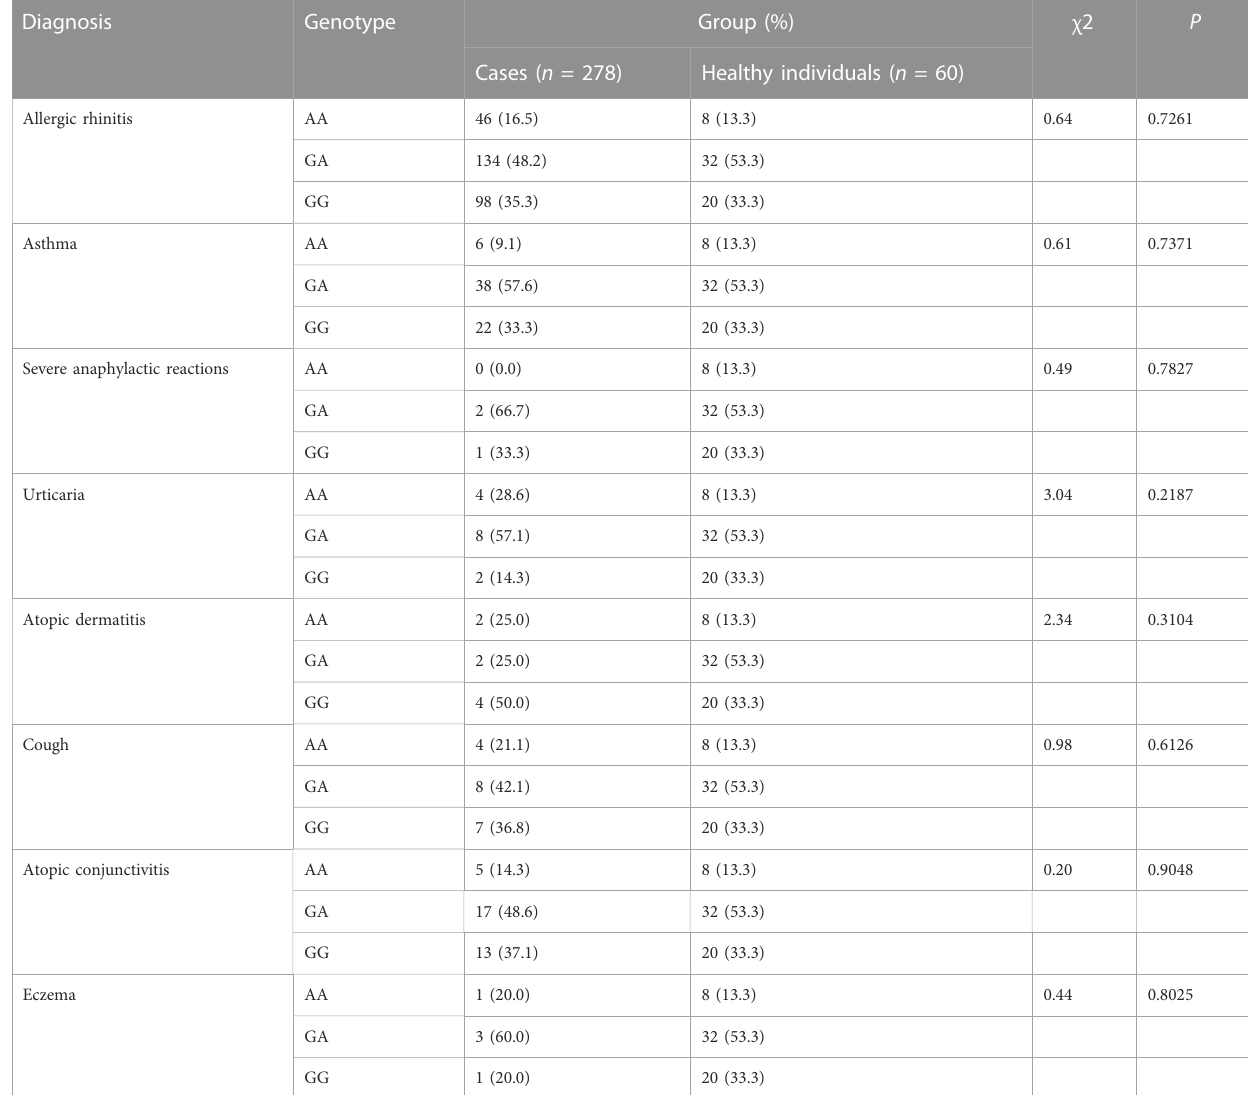
TABLE 7 Analysis of Association of PEAR1 rs12041331 (G2266A) with Genetic Susceptibility to Diagnosis.